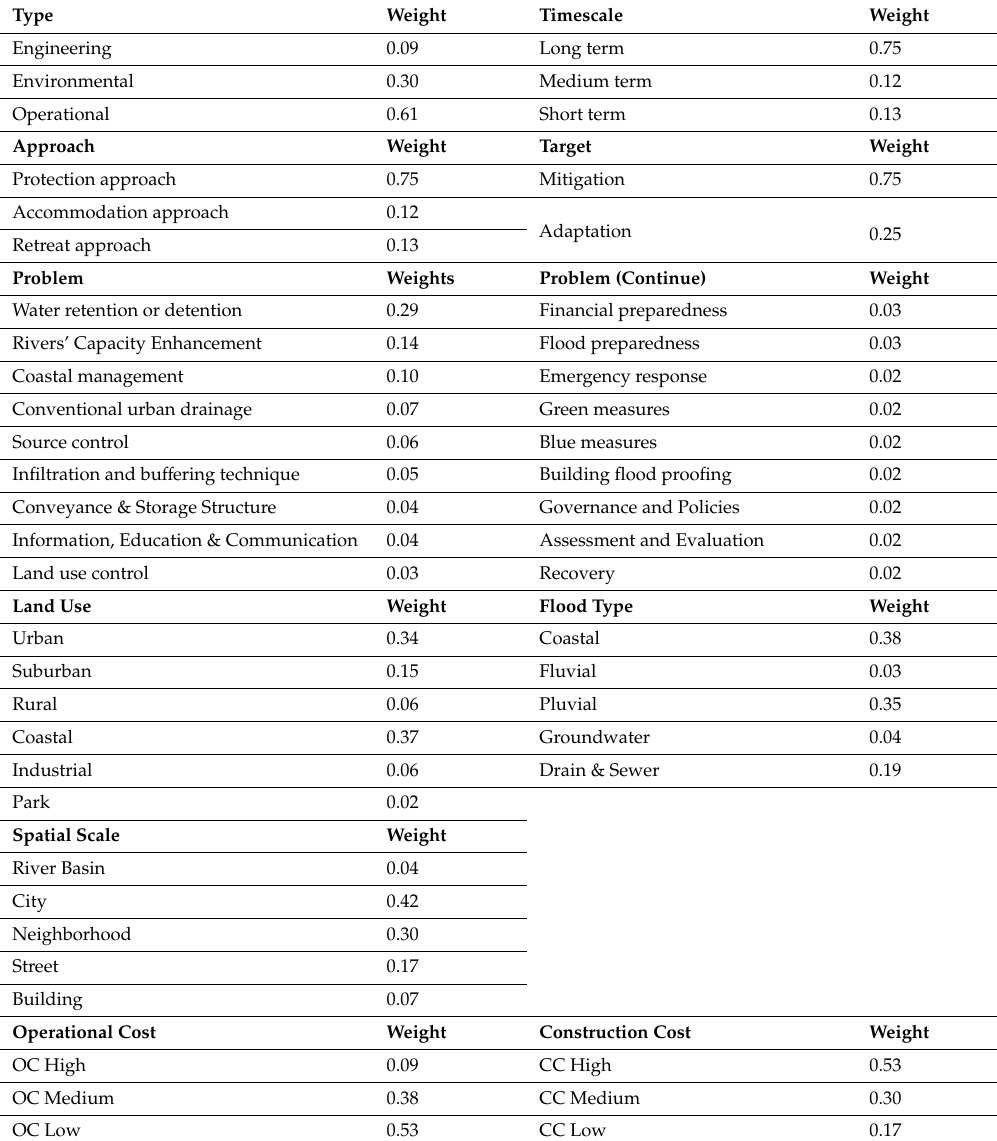
Table 5. Weight of the characteristics of flood resilience measures stored in the